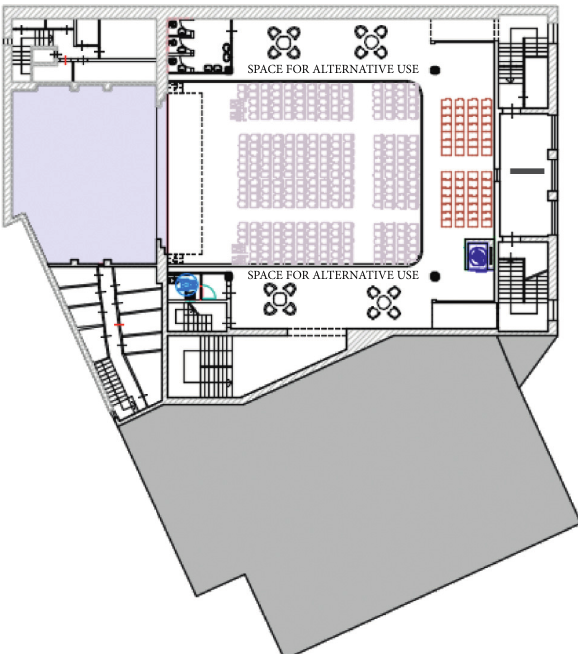
Figure 10: First floor layout.